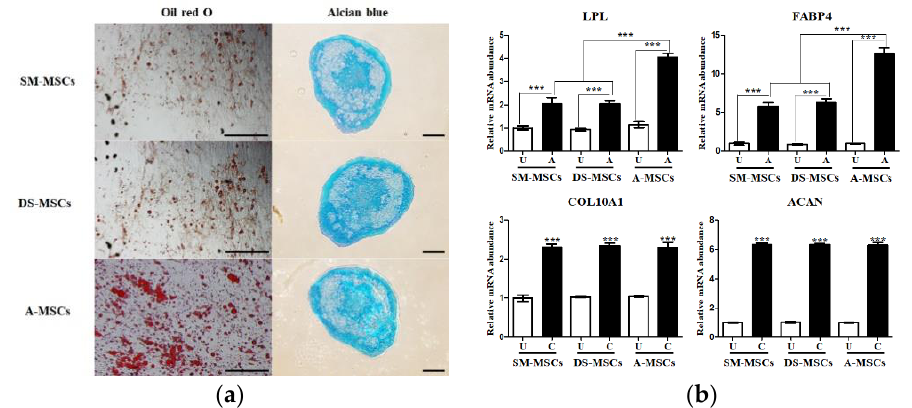
Figure 4. In vitro mesoderm-lineage (adipocyte and chondrocyte) differentiation of MSCs from three types of tissues. ( a ). Adipocytes and chondrocytes differentiation were confirmed oil red O (for adipocytes) and Alcian blue (for chondrocytes) staining. ( b ). The gene expression of adipocytes and chondrocytes-specific markers in differentiated cells. Data are represented by the mean ± SD of four independent experiments. Asterisks indicate significant difference between the undifferentiated cells and differentiated cells (*** p < 0.001). White bar: undifferentiated cells; black bar: differentiated cells; U: undifferentiated cells; A: adipogenic differentiated cells; C: chondrogenic differentiated cells.